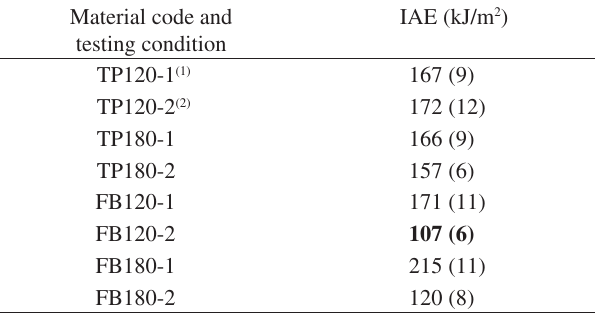
Table 3. Mean results of impact tests under 3PB conditions at room tem- perature and two available energy levels for the mechanical shock. Standard deviation is provided in parenthesis.